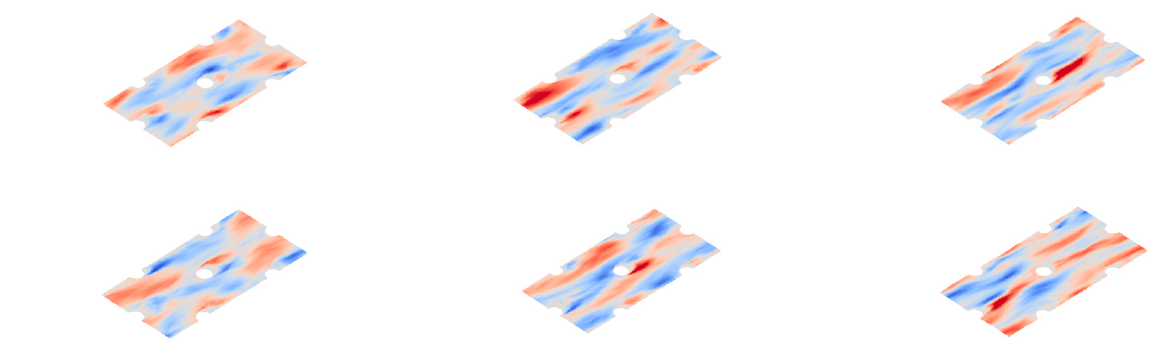
Figure 7. The mode variance distribution for the first 1000 modes and the first eight POD modes of the stream-wise velocity in horizontal planes corresponding to the three levels of roughness height.